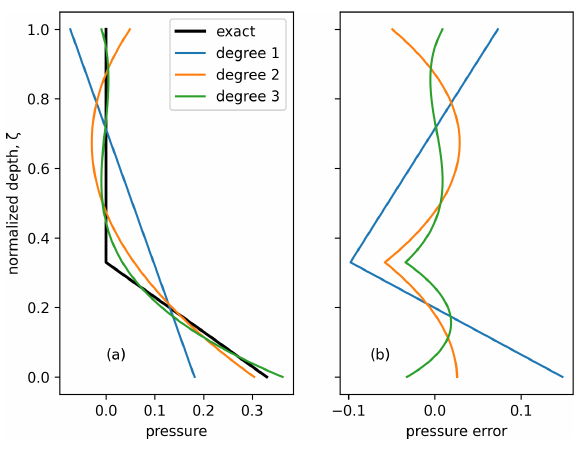
Figure 1. (a) The normalized ocean pressure ( p w /ρ W g ) and Leg- endre polynomial approximations of several degrees, and (b) the residuals of the approximation. For this particular example, the wa- terline is at ζ = 1 / 3, which would be representative of a glacier grounded on a higher moraine. The moments of each of the residu- als up to the approximation degree are all